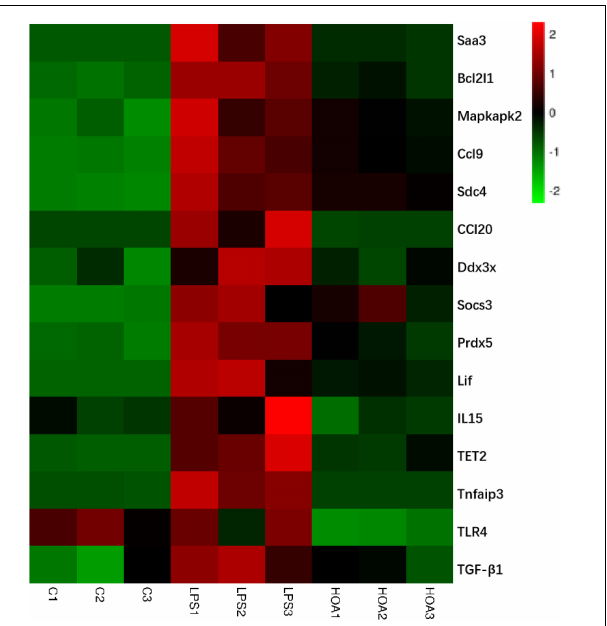
FIGURE 7 | Heatmap of 15 representative immune-related DEGs in C vs. LPS and LPS vs. HOA. Red represents the genes expression were upregulated, green represents downregulated, and black represents no significant difference in genes